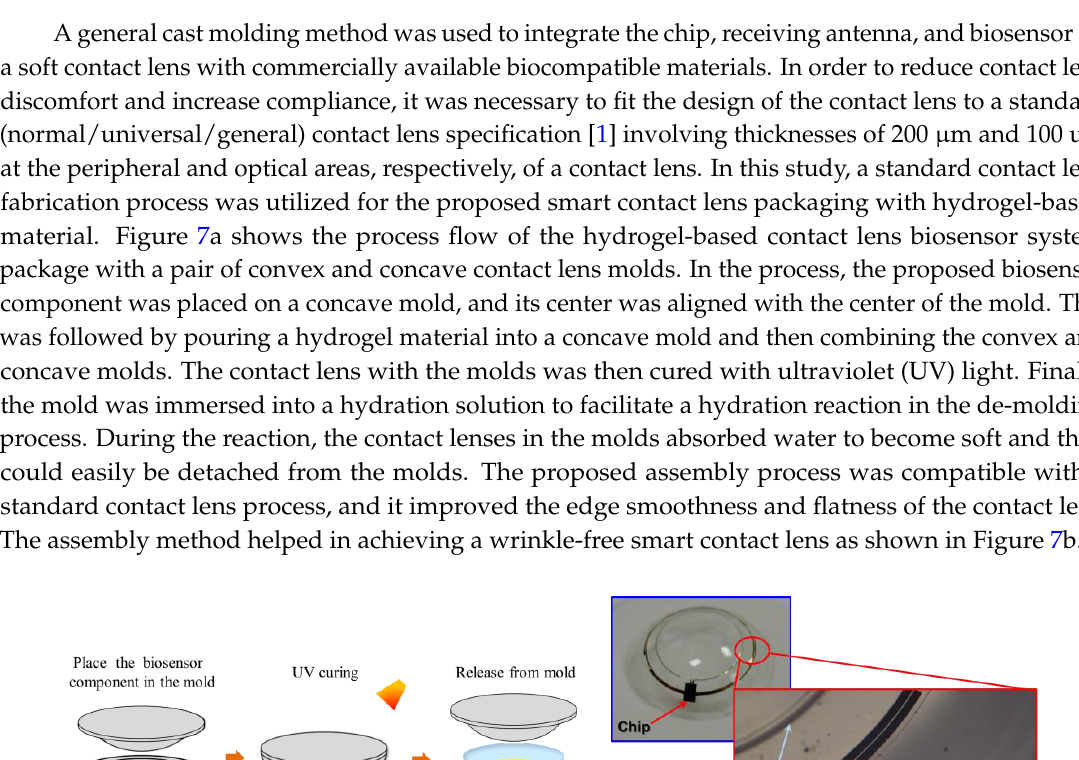
Figure 6. ( a ) A schematic of the proposed reconfigurable CDC; ( b ) Conversion curve and tuning behaviors of CDC.